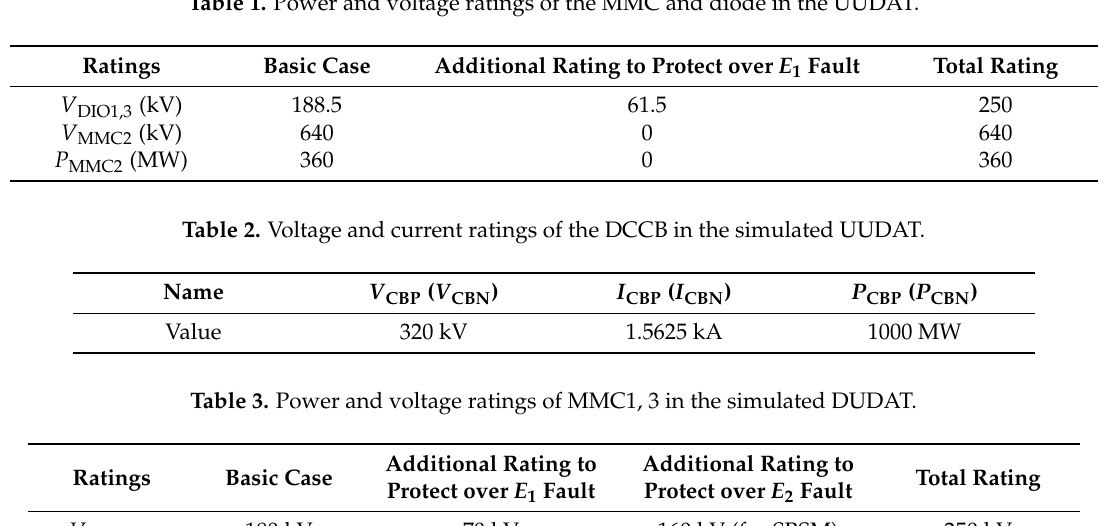
Table 1. Power and voltage ratings of the MMC and diode in the UUDAT.